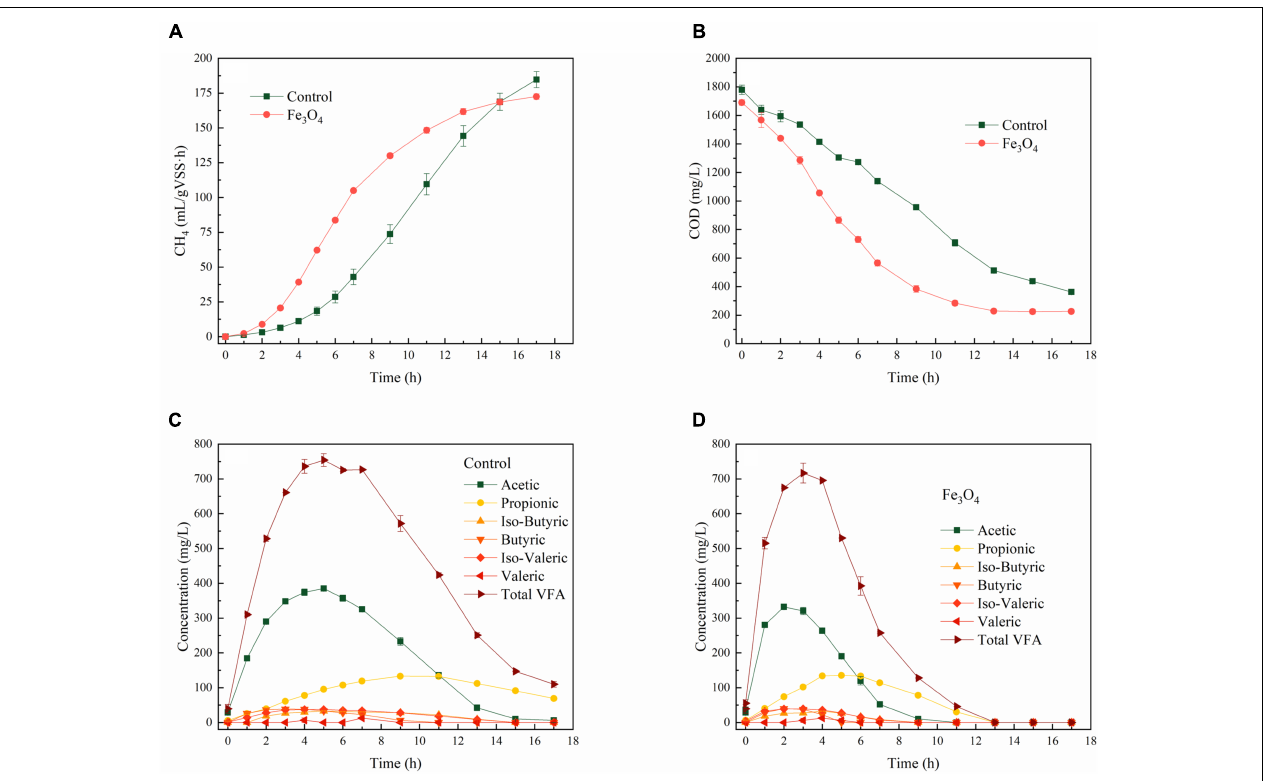
FIGURE 1 | Dynamics of (A) COD, (B) CH 4 , (C) VFAs-control, and (D) VFAs-Fe 3 O 4 within the reaction cycle.